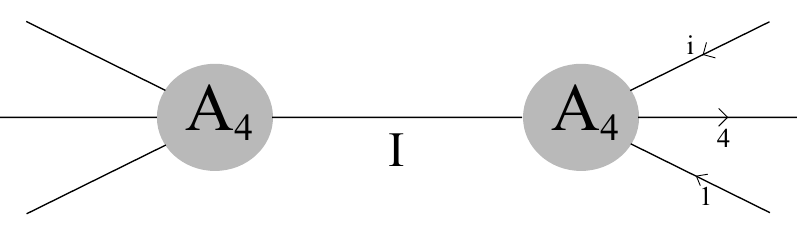
Figure 3 . Sketch of a factorization channel with spurious pole 1 / ( a 4 − a 1 ) where particles 1 and 4 are on the same side with another incoming particle i